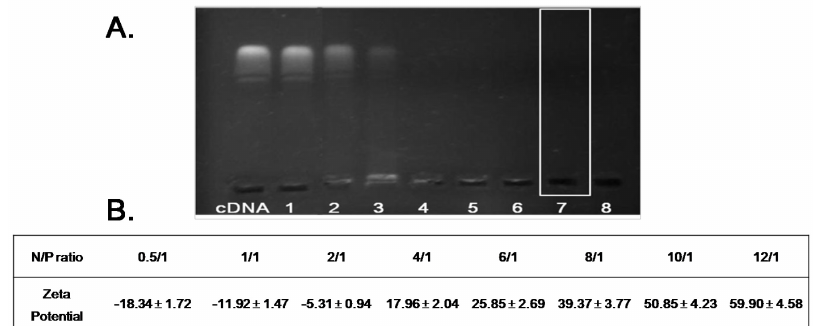
Figure 1. Formation of PEI/DNA complexes. ( A ) Agarose gel electrophoresis retardation assay of PEI/DNA complexes with different N/P ratio. Lanes 1–8: PEI/DNA complexes at N/P ratios of 0.5/1, 1/1, 2/1, 4/1, 6/1, 8/1, 10/1 and 12/1, respectively; ( B ) Zeta potential of